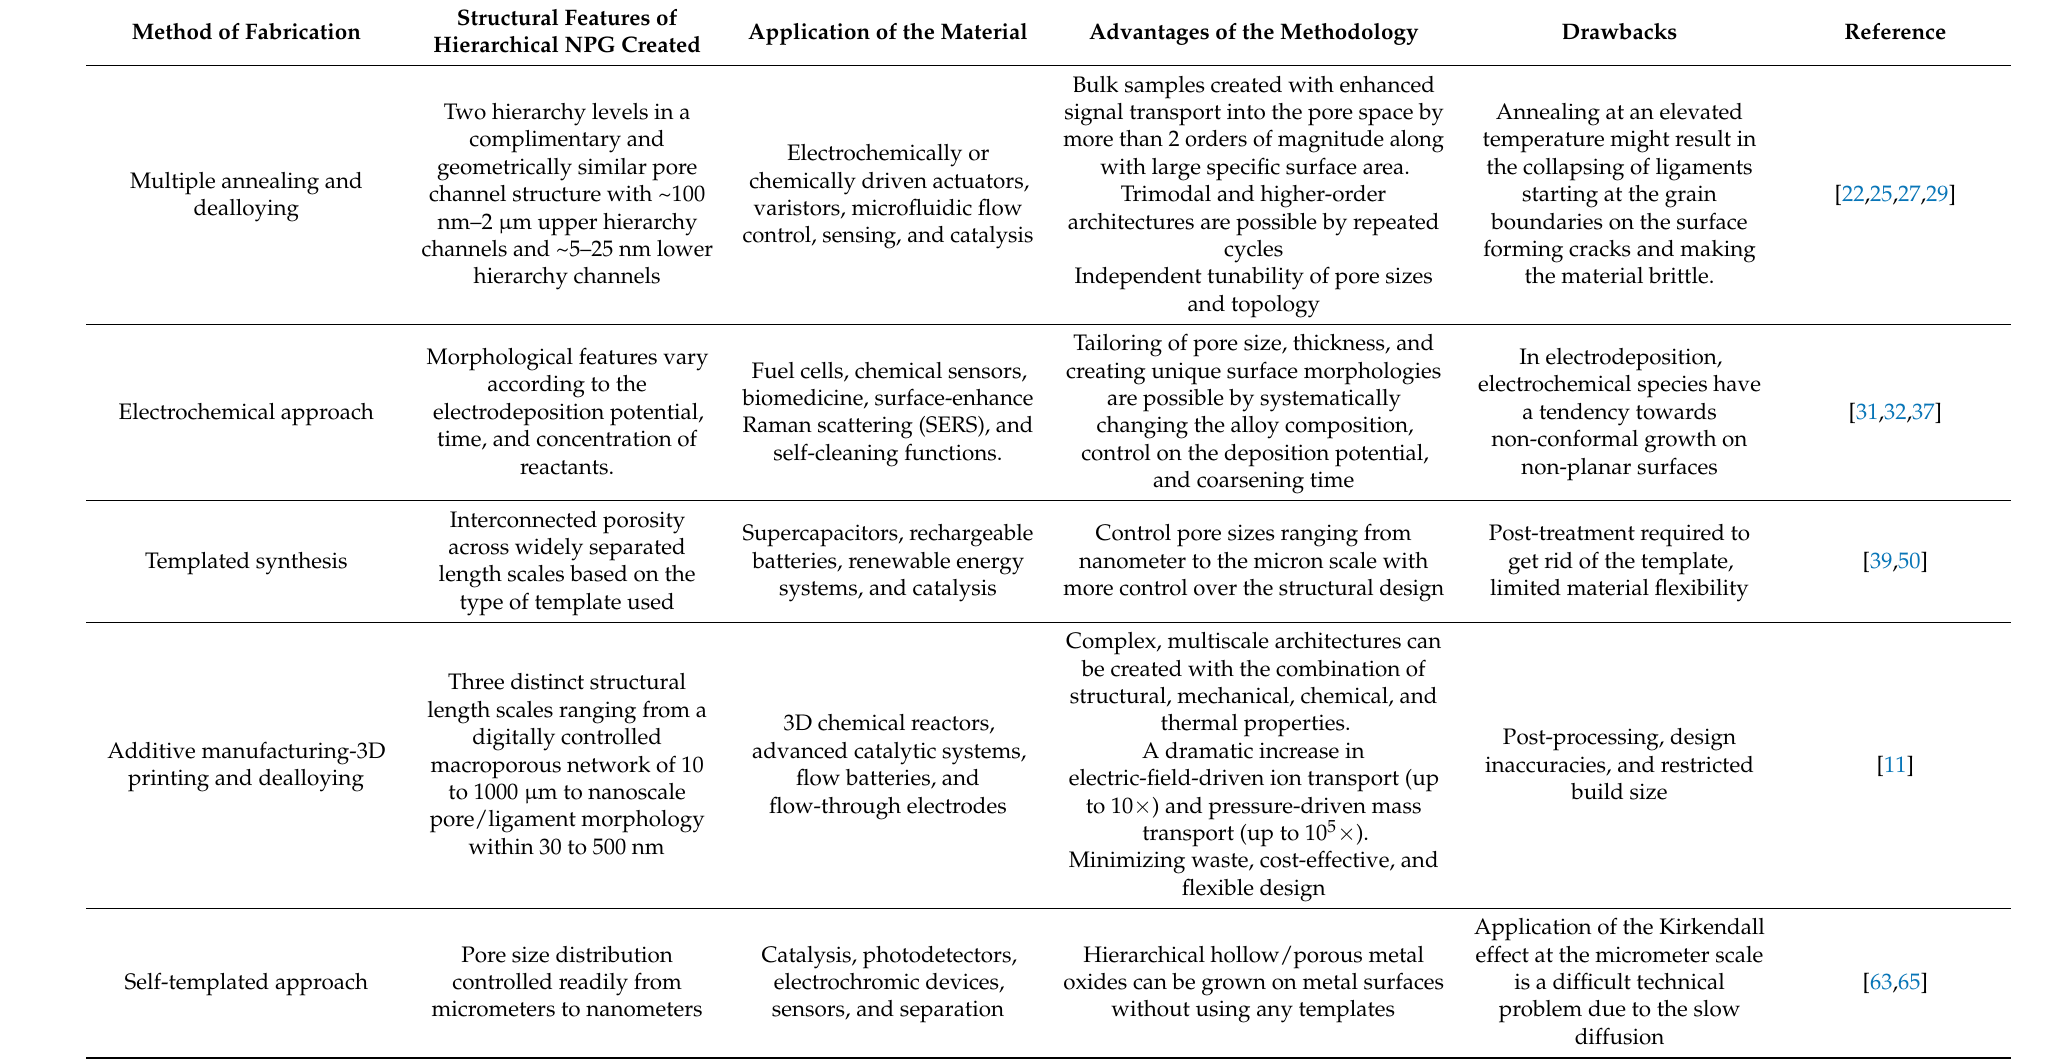
Table 1. Fabrication methods to generate hierarchical nanoporous gold are listed along with the advantages offered by each